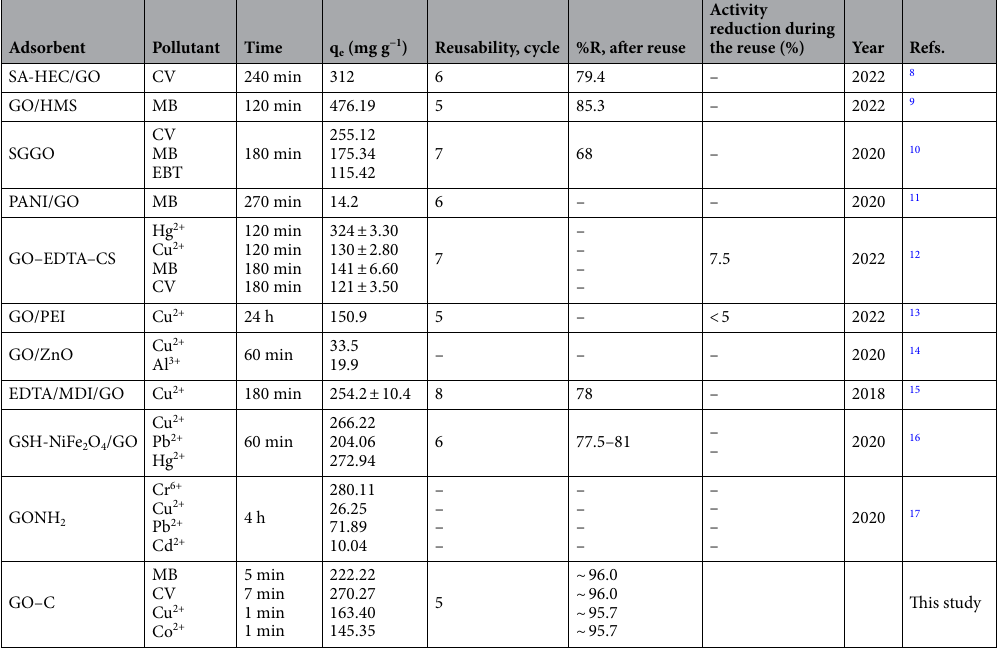
Table 1. GO-based adsorbents for removal of organic and inorganic